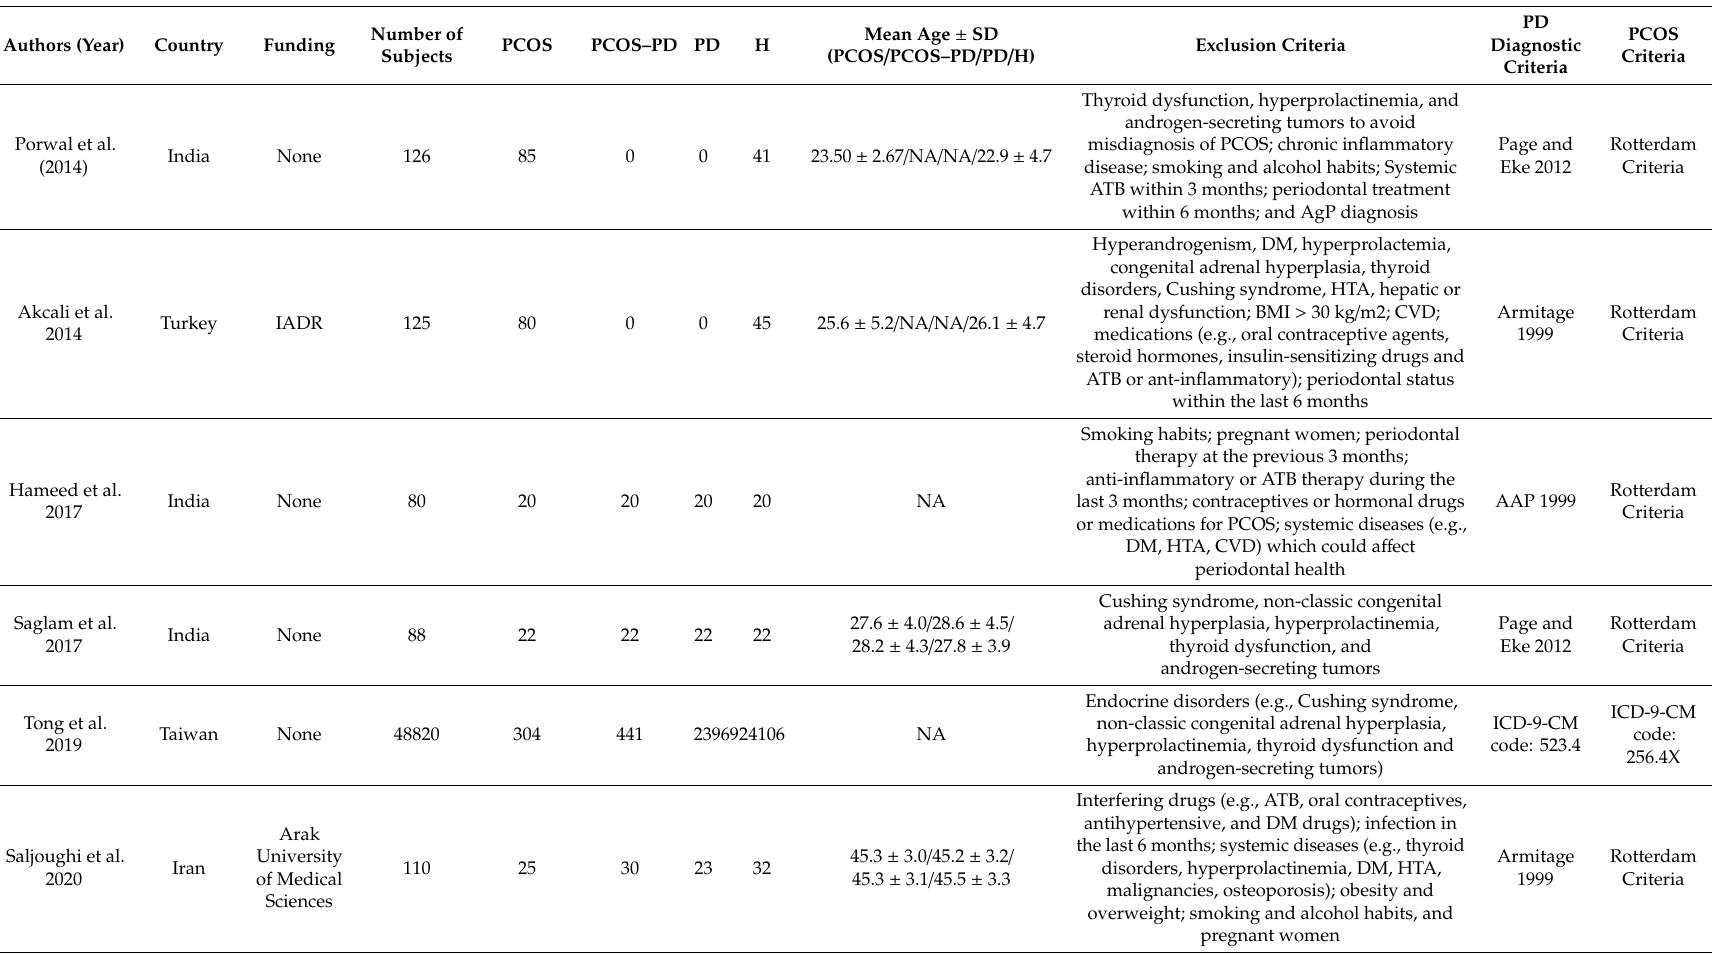
Table 1. Characteristics of the Included